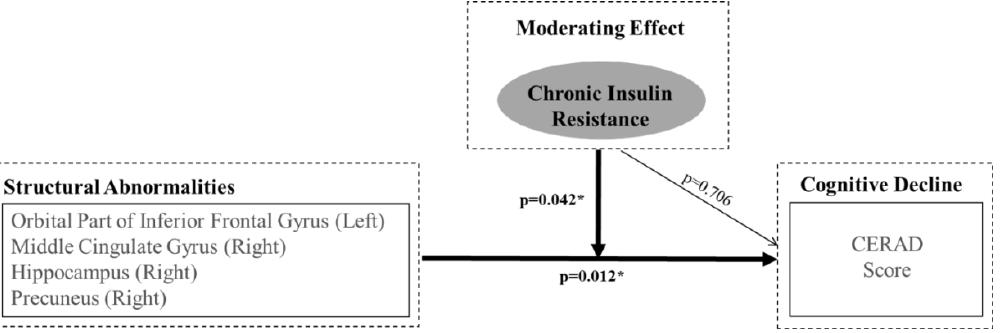
Figure 1. Representation of Hierarchical Moderated Multiple Regression. The orbital area of inferior the frontal gyrus (left), the middle cingulate gyrus (right), the hippocampus (right), and the precuneus (right) are regions where insulin resistance has a moderating effect between structural changes and cognitive